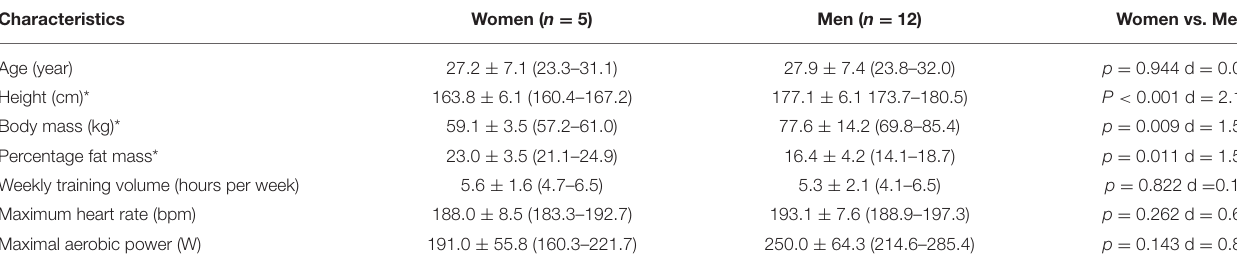
TABLE 1 | Characteristics of the volunteers analyzed.